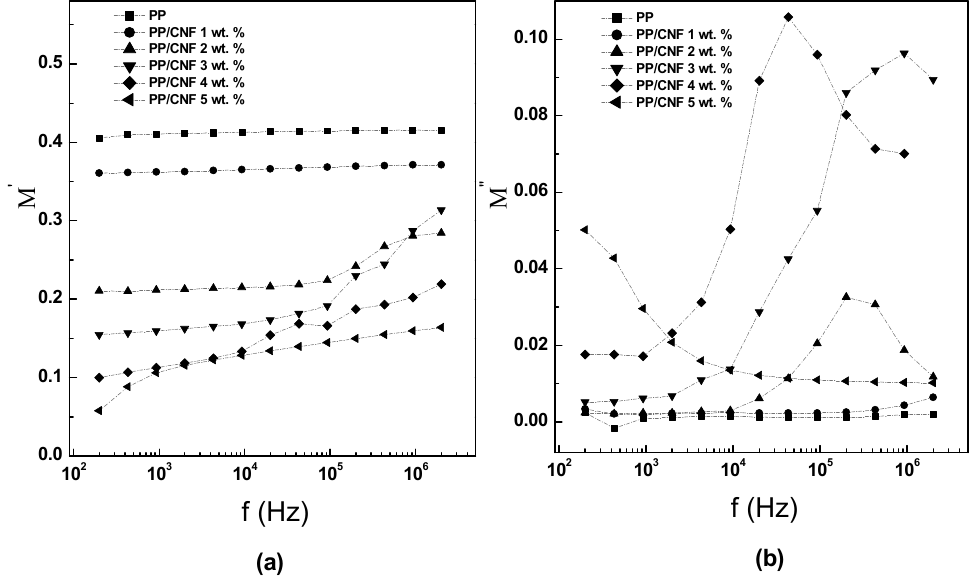
Figure 6. Dependence on frequency of complex electric modulus in PP/CNF composites. Real M (cid:48) ( ω ) ( a ) and imaginary M (cid:48)(cid:48) ( ω ) ( b ) parts of complex electric modulus (the dash-dot lines are to guide the